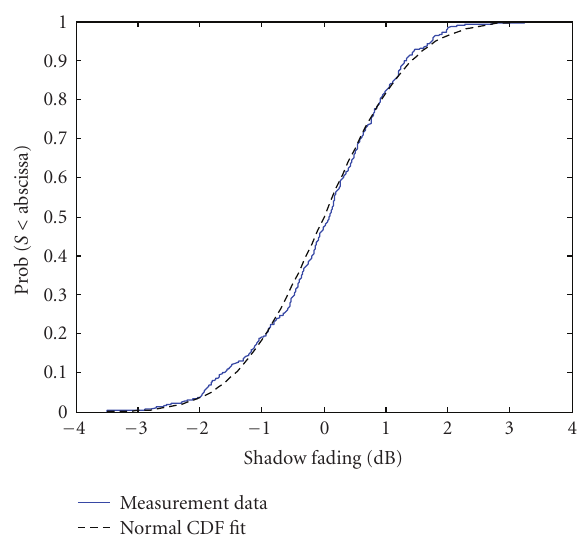
Figure 5: Scatter plot of path loss versus Tx/Rx separation distance. Figure 6: CDF of shadowing fading fit for normal distribution-LOS scenario.